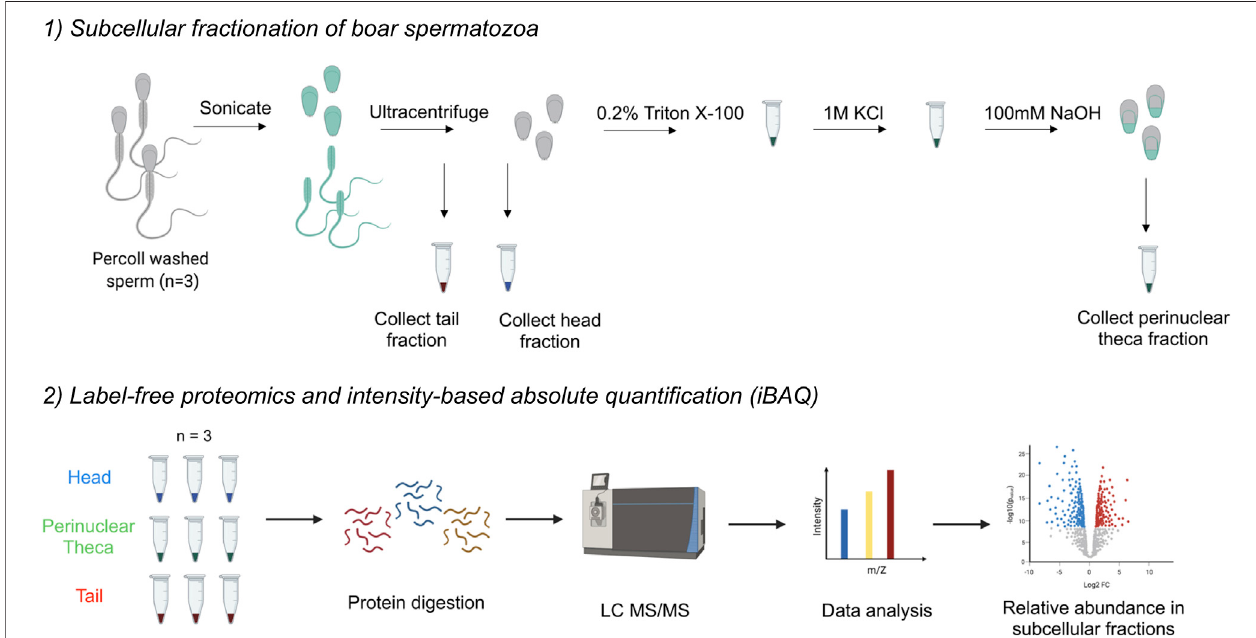
FIGURE 1 | Work fl ow diagram for the isolation ofthe perinuclear theca (PT)and application ofmassspectrometry-based proteomics to boar spermatozoa. 1 ) The separation of sperm heads and tails was performed fi rst through sonication and second, through ultracentrifugation on a 62% sucrose gradient. To isolate the PT structures, boar sperm heads were then subjected to successive extraction steps using 0.2% Triton X100 and 1 M KCl for 1 h each with agitation. The resulting pellets were washed and then incubated in 0.1 M NaOH overnight. The 0.2% Triton X100 solubilizes proteins associated with the inner acrosomal membrane, 1 M